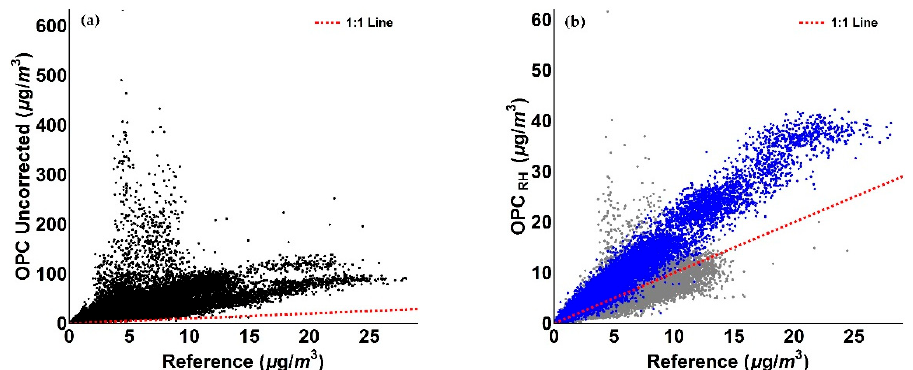
Figure 12. Figures illustrating the comparison of OPC measurements with reference data for PM 2.5 values. ( a ) Scatter plot of reference and uncorrected OPC PM 2.5 measurements relative to the period between 17 December 2017 and 16 January 2018; ( b ) Scatter plot of reference and OPC RH-corrected PM 1 measurements relative to the period between 17 December 2017 and 16 January 2018. The colour scheme reflects the blue and grey shaded areas in Figure 10c.